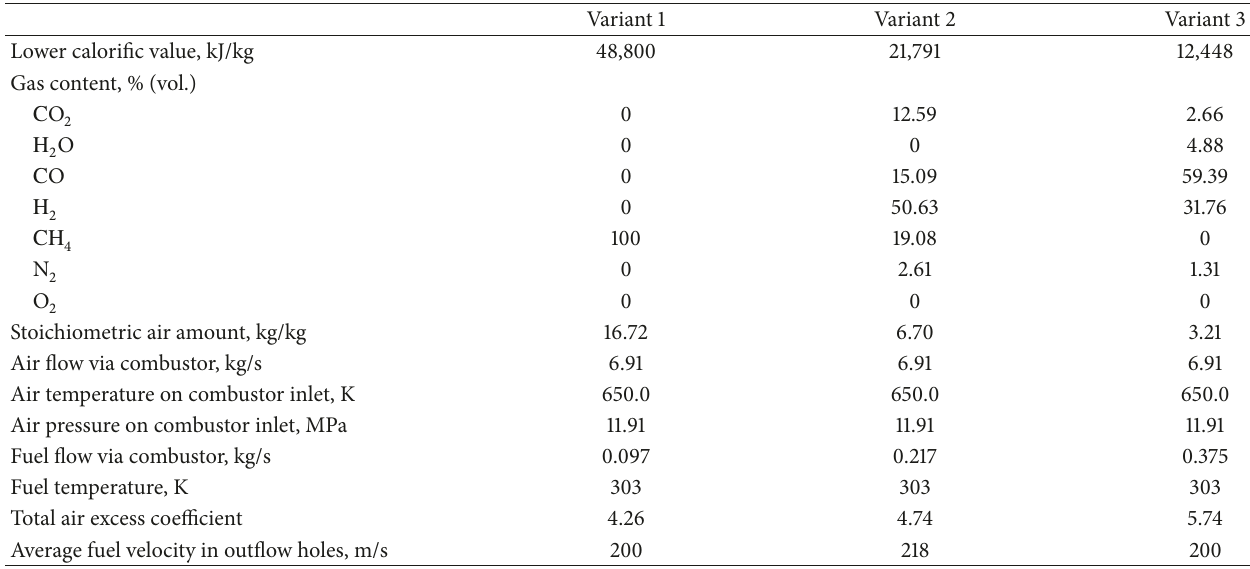
Figure 2: Experimental and calculated dependence of air consumption via the ejector on air consumption via the combustor: (a) cool blow mode; (b) hot blow mode. Table 3: Gas turbine combustor calculation initial data.